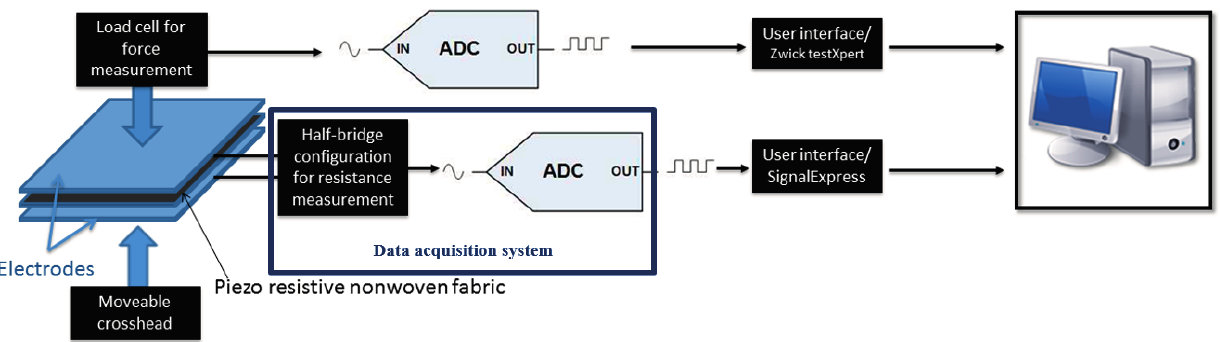
Figure 1. Subject wearing the prototype safety belt.